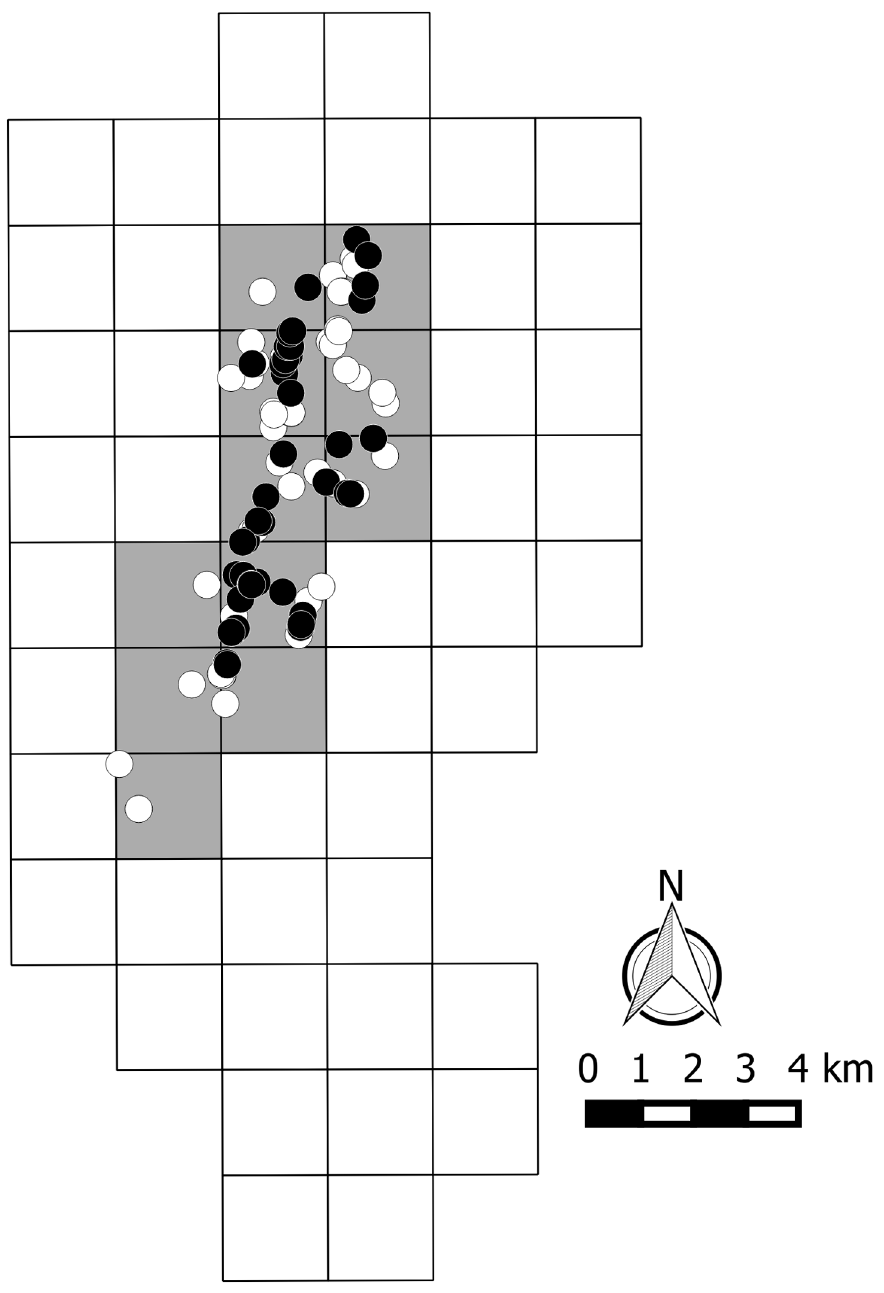
Fig 2. Occurrences of Candidula coudensis . Location of living Candidula coudensis (black dots) and empty shells (white dots) within the 2 x 2 km grid used to sample this land-snail species. Grey grid squares correspond to species presence (either live or